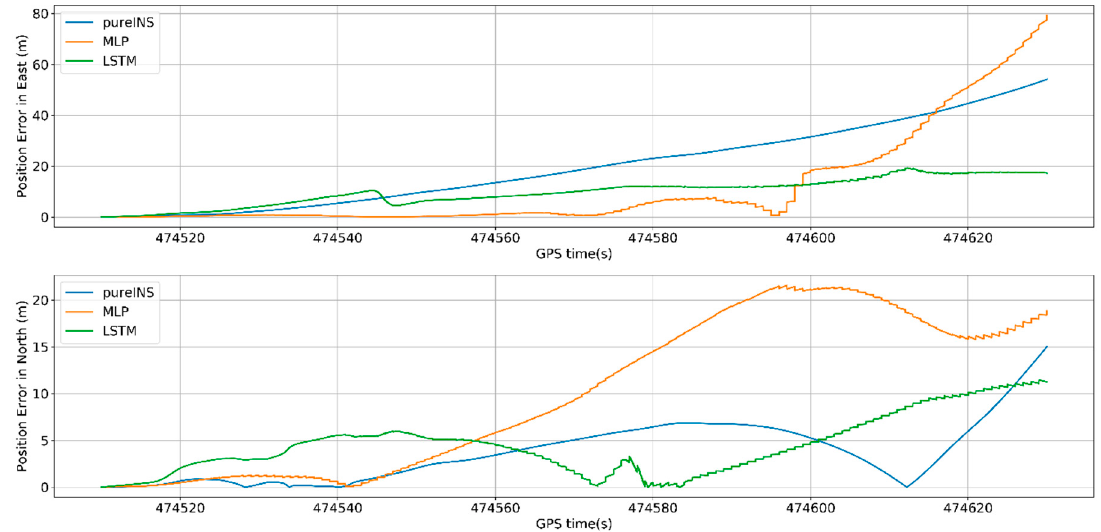
Figure 16. Position errors of 120 s outages with different algorithms.